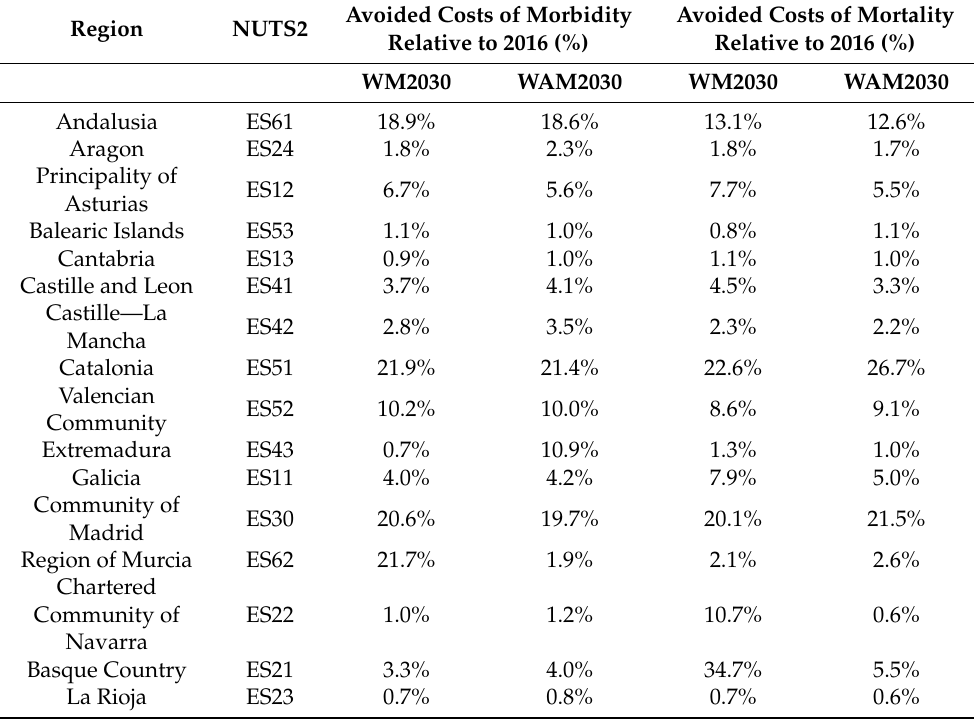
Table 3. Distribution of the reduction in external costs by NUTS2